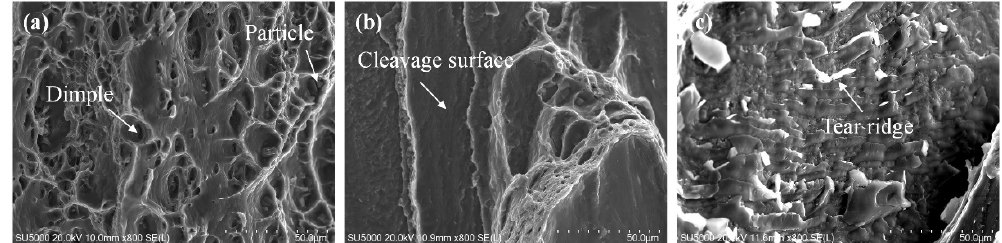
Figure 15. Fracture surfaces of SFSW at ( a ) 800 rpm, ( b ) 900 rpm, and ( c ) 1000 rpm.